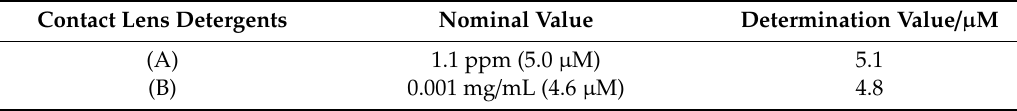
Table 2. Determination of PHMB in contact lens detergents.